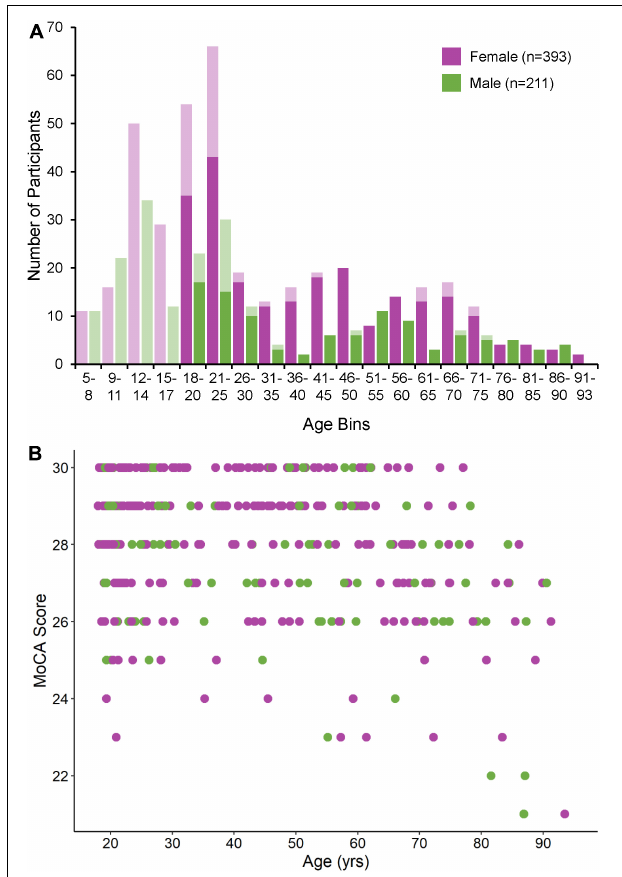
FIGURE 2 | (A) Age distribution for male and female participants included in the final study cohort. Age bins vary in size from 3 to 5 years, with smaller bins used before the age of 20 and larger bins used afterward. Opaque bars indicate participants aged 18 and older for which MoCA scores were available. (B) MoCA score distribution for male and female participants depicted by the opaque bars in panel (A)